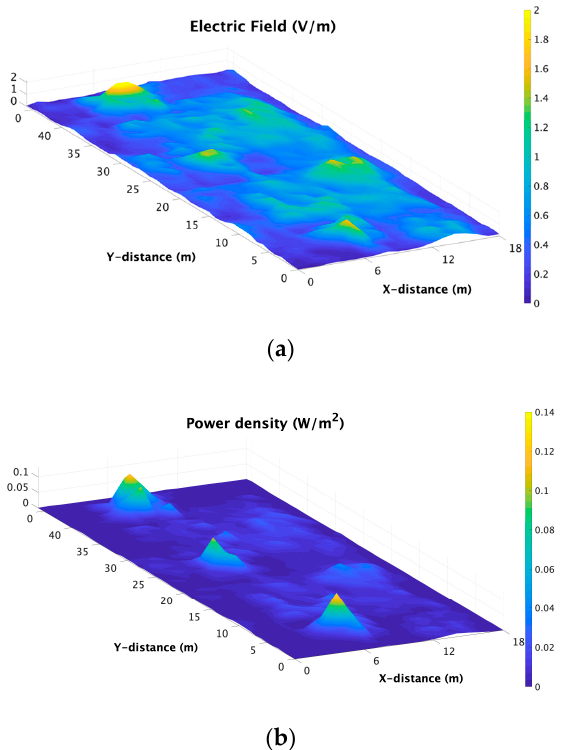
Figure 13. E-field and Power density distribution levels of the XY bi-dimensional plane at the working spaces at head height of seated people on the first floor of the library for Case III HD: ( a ) E-field and ( b ) power density.